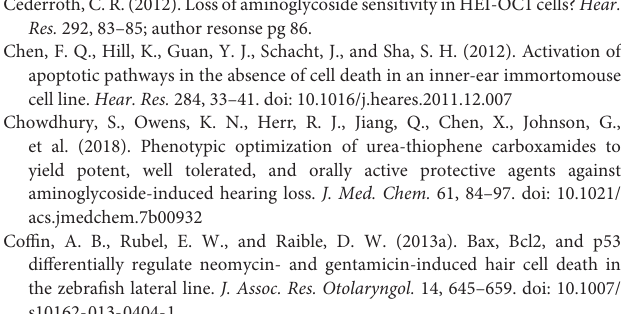
FIGURE S1 | A Pearson correlation heatmap matrix of gene expression changes in heat shock signature genes in cultured utricles following exposure to either heat shock, AEG3482, Pifithrin- µ , AT13387, AZD-6482, or DMSO vehicle. The color shading within the heatmap corresponds to the degree of correlation. Red indicates a positive correlation coefficient between two treatments; white signifies a lack of correlation, and blue signifies a negative correlation coefficient. TABLE S1 | The gene names recognized by the LINCS query tool. The 115 enriched genes recognized are displayed in the top half of the table, and the 28 depleted genes recognized are displayed in the bottom half. Genes are displayed in alphabetical order for both enriched and depleted